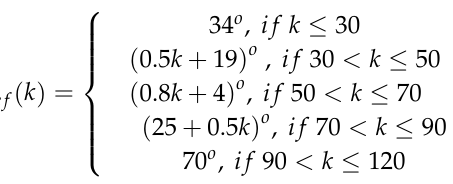
Figure 27. Learning curve of the FNFN controller in the water bath system.